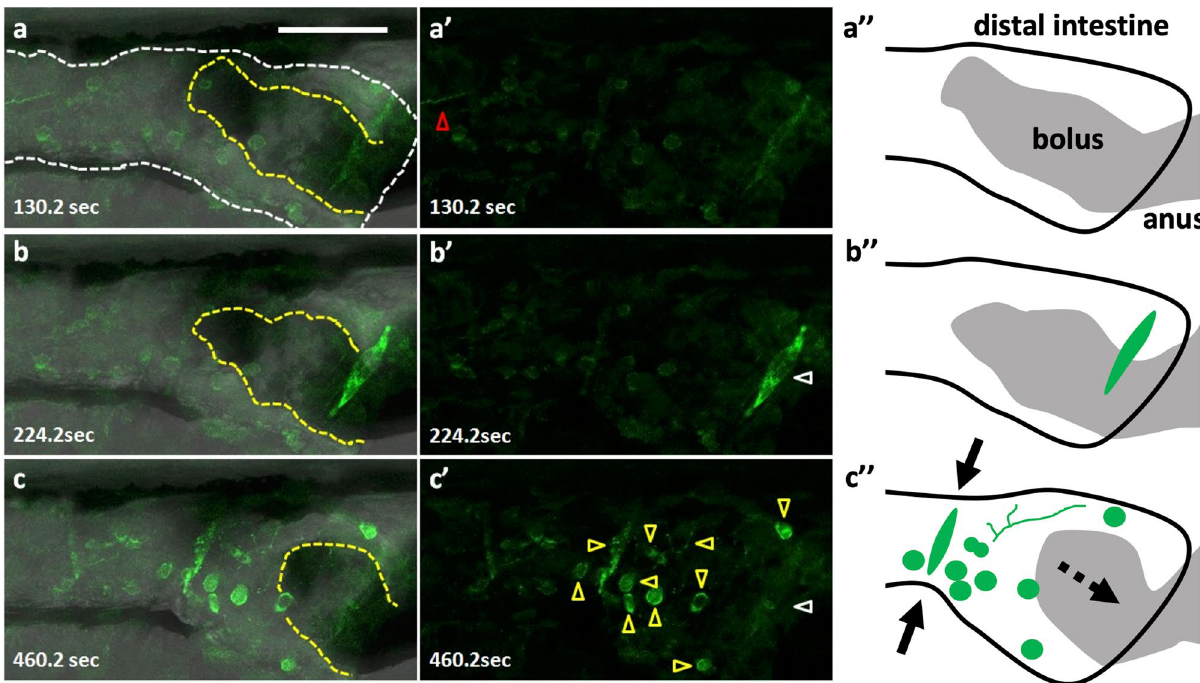
Figure 3. Peristaltic reflex visualized by Ca 2+ imaging of a variety of cell types including putative enteric neurons and circular smooth muscles. Live images of putative enteric neurons and circular smooth muscles expressing GCaMP3 at 8 dpf in Tg(hsp70: Gal4); Tg(UAS: GCaMP3), heat-shocked at 6 dpf. The passage of the bolus was blocked at the anus by agarose gel, in an artificial condition of constipation. ( a–a’’ ) the phase when most of the activity is arrested but an activated fiber with a distinct rhythm extends from the oral side (red triangle). ( b–b’’ ) the phase when only the putative circular muscles at the anal side (white triangle) located on the bolus (yellow dashed lines) are activated. ( c–c’’ ) the phase when the putative circular muscles located at the oral side of the bolus are activated together with most of the putative neurons and axons in the view (yellow triangles) ( a – c ), merged image; ( a’–c’ ), fluorescence; ( a’’–c’’ ), schematic drawings. Solid arrows indicate a contraction of the gut and a dashed arrow, the movement of the bolus. Lateral views. Anterior to the left. Scale bar, 50 μm. Also see Supplementary video